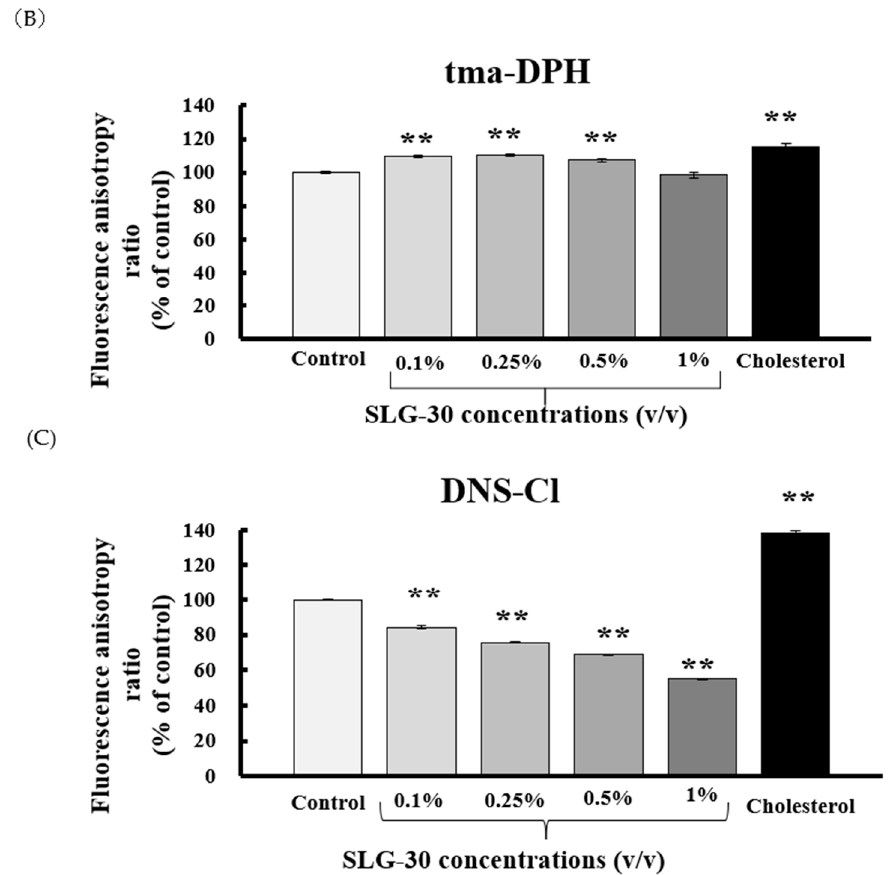
Figure 3. The effect of SLG-30 on the membrane fluidity of brush-border membrane vesicles (BBMVs). DPH ( A ), tma-DPH ( B ), and DNS-Cl ( C ) were used as fluorescein probes of inner lipid bilayers, outer lipid bilayers, and the protein portion of the enteric membranes. The absolute concentrations of DPH, tma-DPH, and DNS-Cl were 1 µ M, 0.5 µ M, and 5 µ M, respectively. The results are expressed as the mean ± S.E. ( n = 4). ** p < 0.01, n.s. not significantly different when compared with the control.